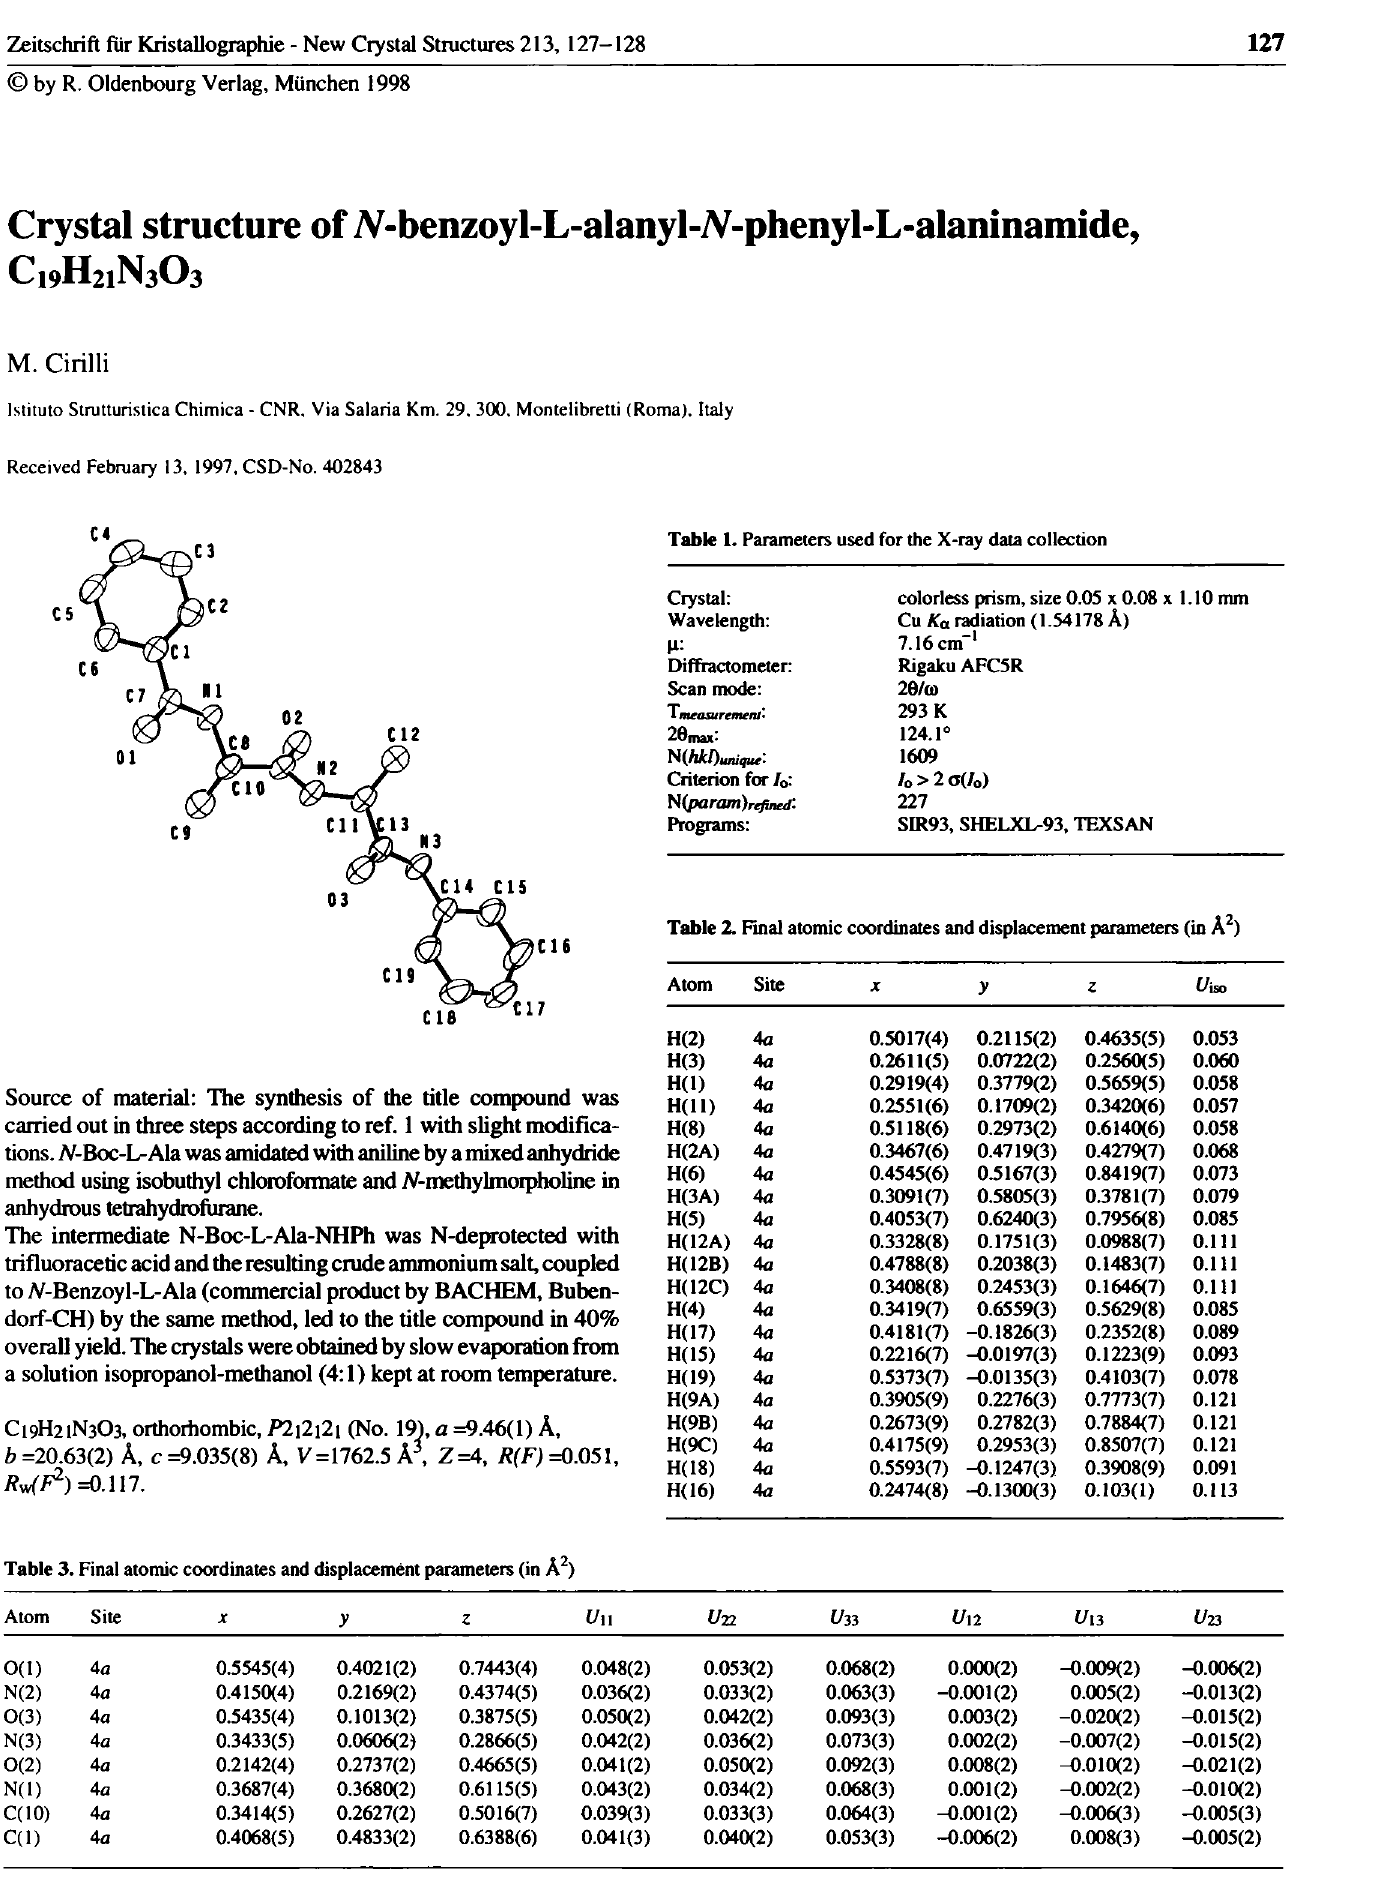
Table 1. Parameters used for the X-ray data collection